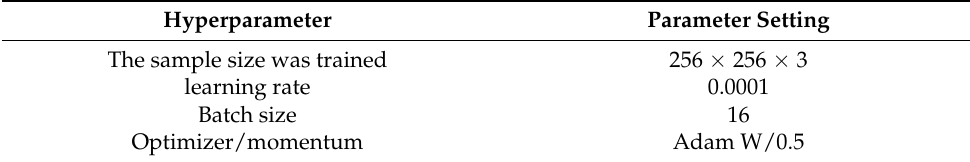
Table 2. Experimental hyper-parameter settings.